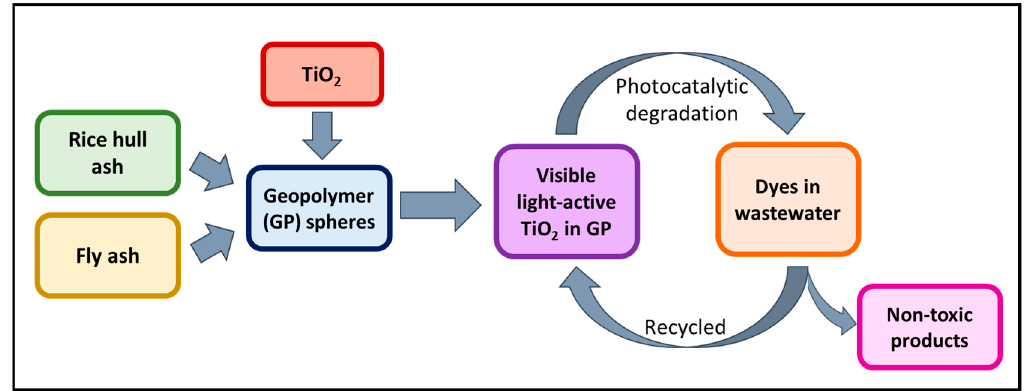
Figure 1. Schematic diagram of the overall process employed in this study for the photodegradation of organic dye in wastewater using visible-light-active titania.